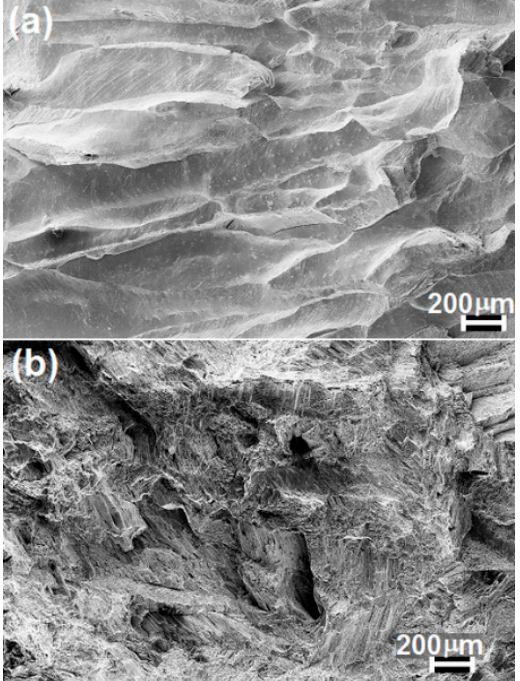
Figure 10. Fractography of Co-20 wt. % Cr alloy: ( a ) in the as-chill cast condition and ( b ) heat-treated